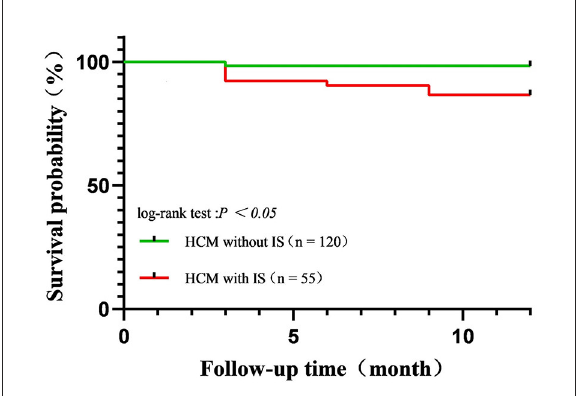
FIGURE2 Kaplan–Meier curves for survival rate in patients with hypertrophic cardiomyopathy complicated by ischemic stroke (IS) and HCM complicated without IS. Overall, the 1-year survival rate was 81.8% in patients with HCM with IS and 96.7% in patients with HCM without IS.